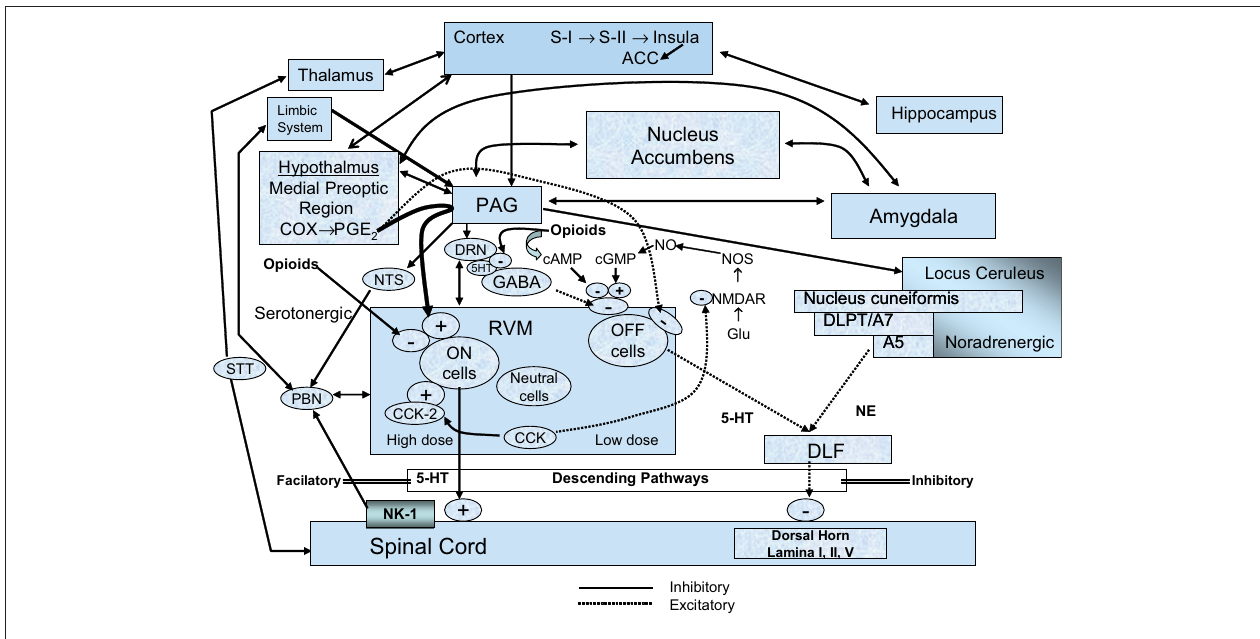
Figure 2 | Potential supraspinal/spinal modulation of